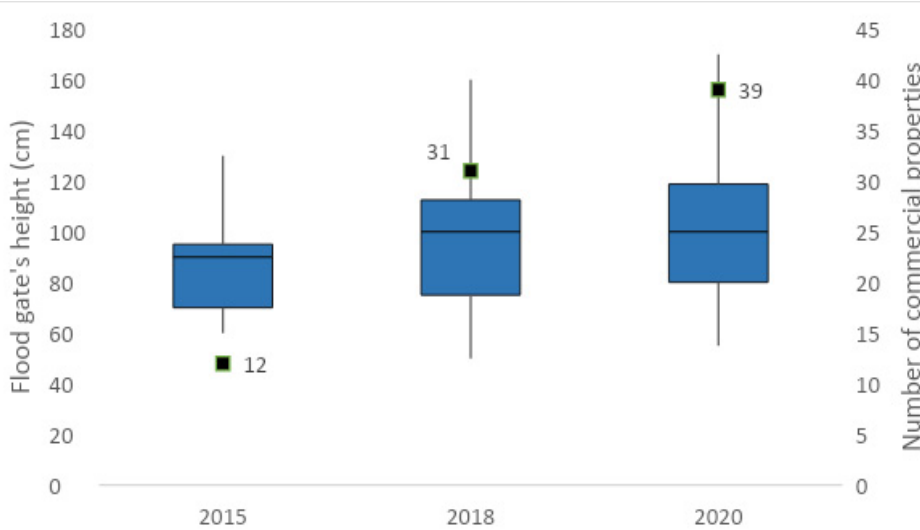
Figure 7. Variation in the height of the gates installed in the stores analyzed between the years 2015, 2018 and 2020. The square shows the number of stores with gates among the 52 stores studied each year.